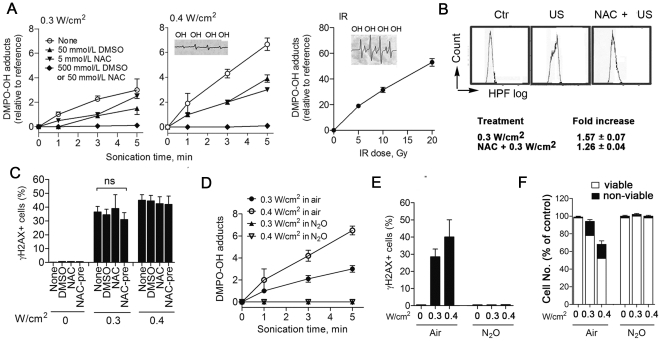
Linking mechanical US effect withinduction of γH2AX+ cells.(A) EPR detection of US- or IR-induced extra- and intracellular levels of OH• as DMPO-OH adducts (see Methods); Increase of OH• levels in DMPO solution (10 mmol/L) as a function of insonation time at 0.3 (left) and 0.4 (middle) W/cm2 US, or at IR dose of 5–20 Gy (right, closed circle). Induction of DMPO-OH adducts by 0.3 or 0.4 W/cm2 were reduced partially by 50 mmol/L DMSO (upward triangle) or 5 mmol/L NAC (downward triangle), and nullified by a 10-fold higher concentrations: 50 mmol/L NAC or 500 mmol/L DMSO (closed diamond for both). The insets show amplitudes of EPR signals of DMPO-OH. (B) FCM-based HPF assay for intracellular OH• levels immediately after 0.3 W/cm2 US in U937 cells. The histogram shift toward high-HPF fluorescence by OH• oxidation was small, and thus, an increase in mean fluorescence intensity (MFI) was 1.57±0.07 fold the control (n = 3, mean ± s.d.), with partial protection by pretreatment with 5 mmol/L NAC for 3 h before sonication. (C) No protective effects of 5 mmol/L DMSO or 5 mmol/L NAC (scavengers) added to cultures immediately before 0.3 and 0.4 W/cm2 US, or other 3 h-pretreatment with 5 mmol/L NAC (NAC-pre) against the induction of γH2AX+ U937 cells 30 min post-US. (n = 3, mean ± s.d. ns means not significant). (D–F) Saturated N2O gas caused the abrogation of US-induced events as follows: (D) The US exposure-time dependent induction of OH• in 10 mmol/L DMPO solution at 0.3 and 0.4 W/cm2 (n = 3, mean ± s.d.). : (E) The induction of γH2AX+ U937 cells 30 min after 0.3 and 0.4 W/cm2 (n = 3, mean ± s.d.). : (F) 20% non-viable cells (trypan blue dye exclusion test) and 30% loss in cell counts relative to control U937 cells 6 h after 0.3 or 0.4 W/cm2 US (n = 3, mean ± s.d.).